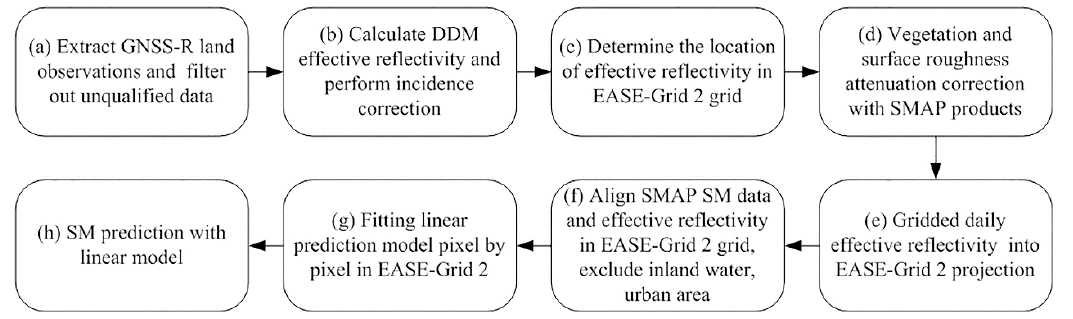
Figure 4. Spaceborne GNSS-R SSM retrieval algorithm flow chart.